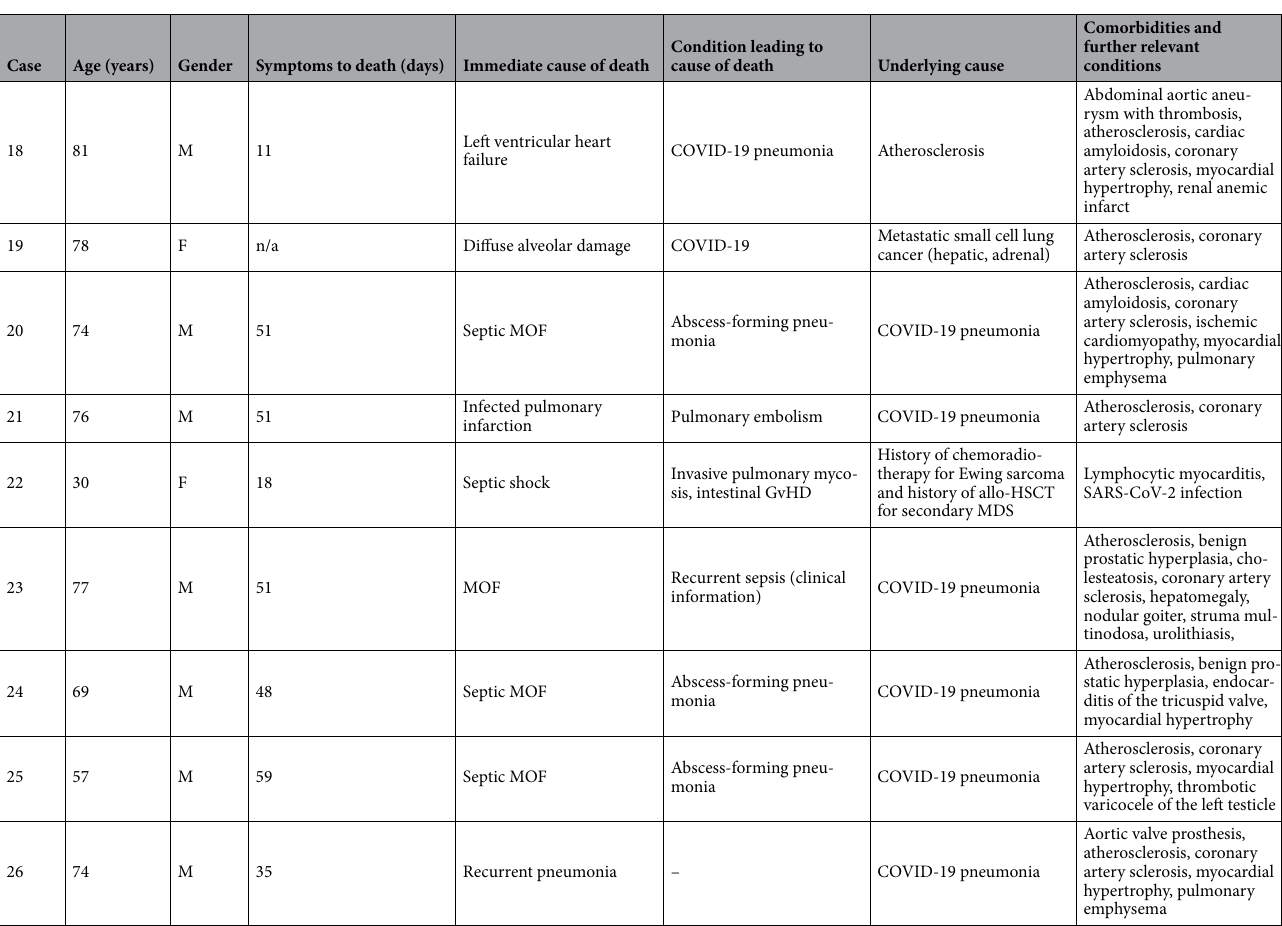
Table 2. Causes of death and comorbidities in patients with COVID-19 as determined by autopsy. M male, F female, n/a not available, COVID-19 coronavirus disease 2019, COPD chronic obstructive pulmonary disease, stem cell transplantation, MDS myelodysplastic